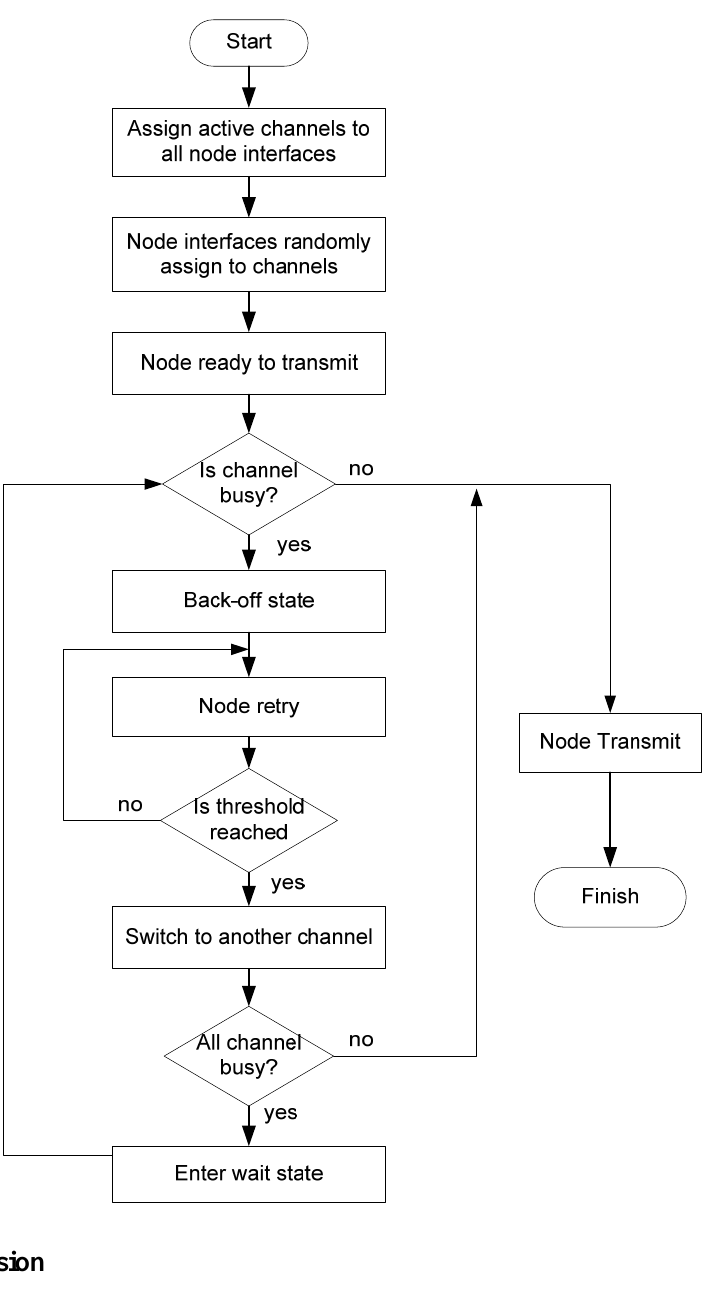
Figure 5. Flow chart for channel